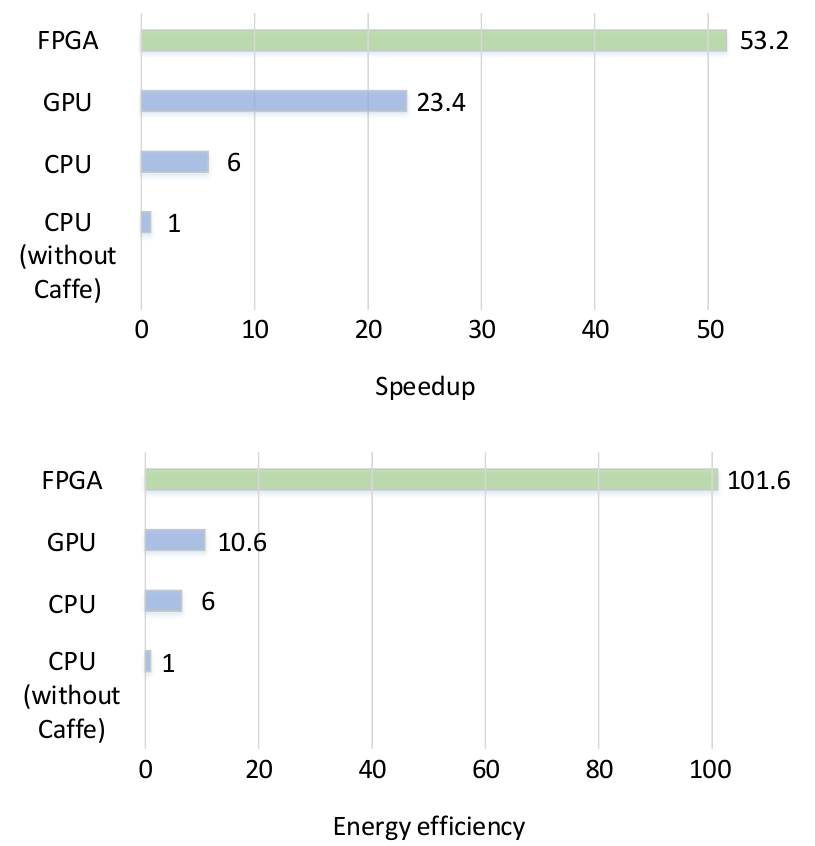
Figure 10. Speedup and energy efficiency on different